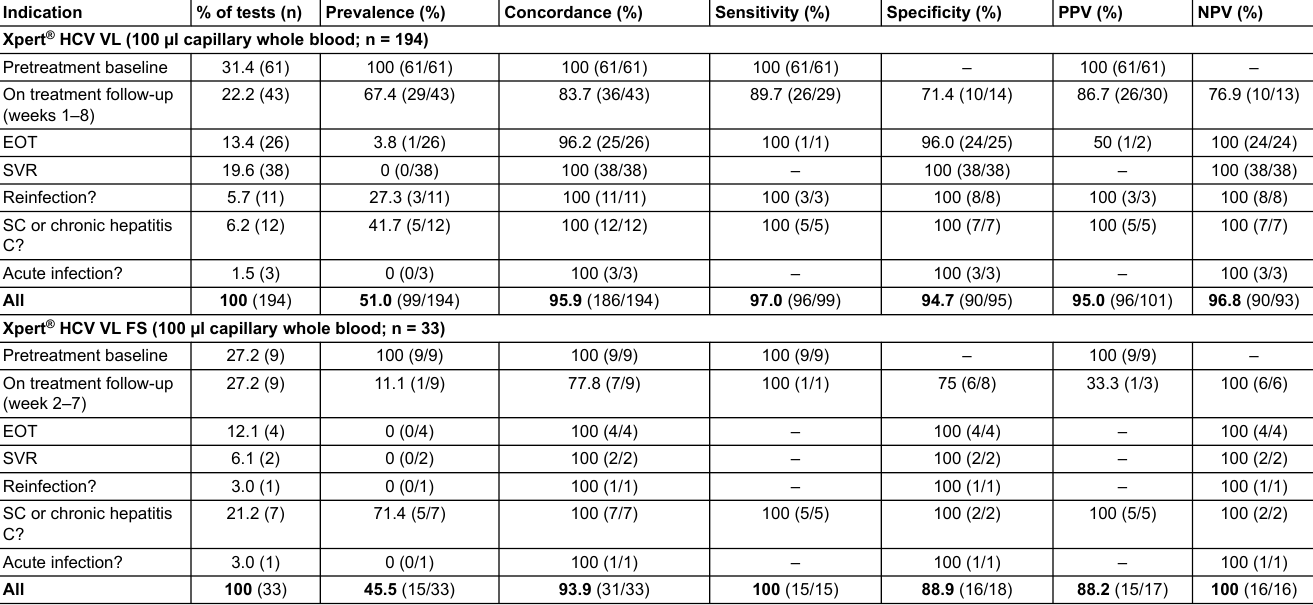
Table 3: Performance according to indication – Xpert ® HCV Viral Load (VL) and Xpert ® HCV Viral Load Finger-Stick (VL FS) tests. Indication